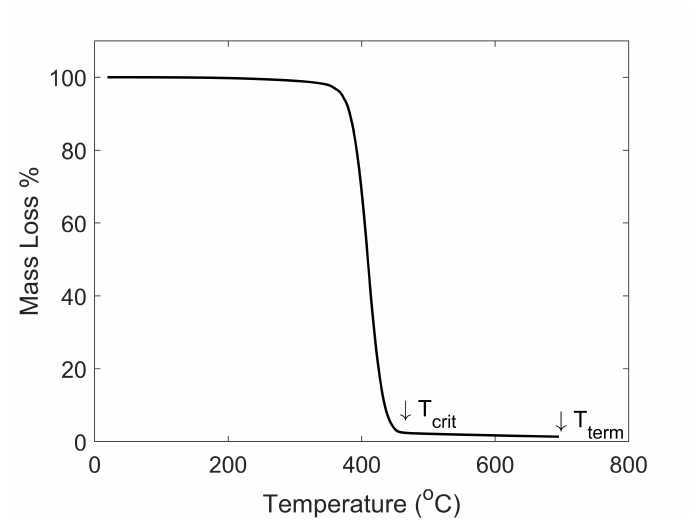
Figure 6. Example Analysis for T crit and T term (ABS). T crit refers to the temperature at the end of the single-stage degradation while T term is the temperature at the end of the test. The mass percentage is reported at both T crit and T term for all the materials used as shown in Table